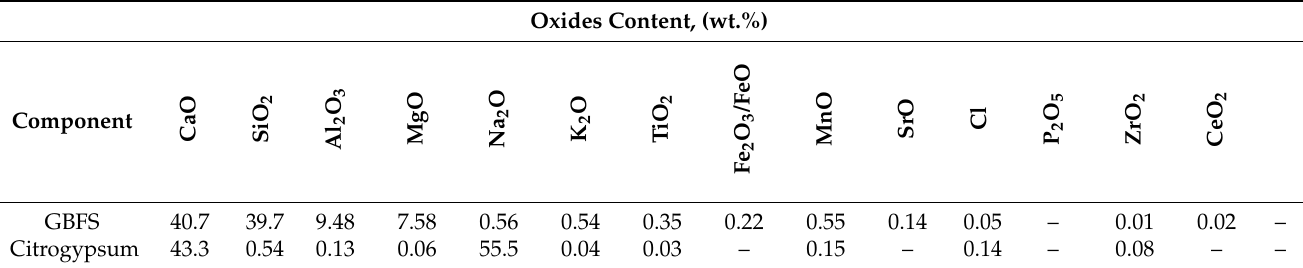
Table 3. Chemical composition of GBFS and citrogypsum. Oxides Content,